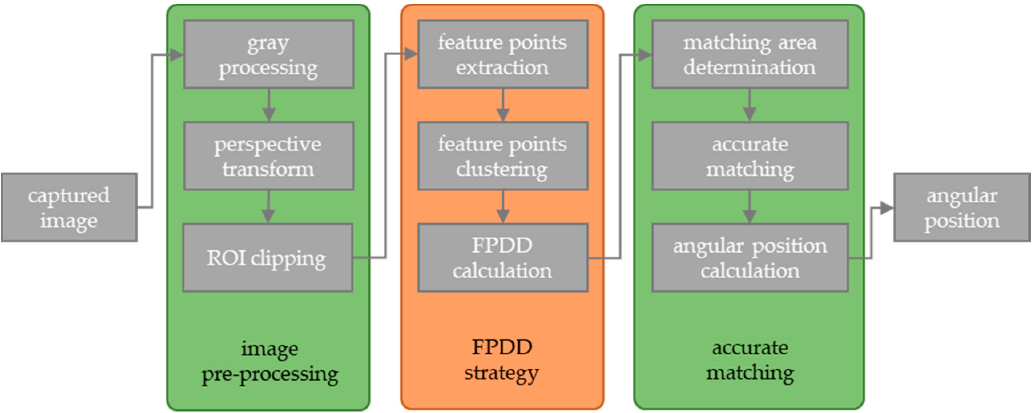
Figure 5. Workflow of the proposed spool ‐ angular ‐ position ‐ measuring method.